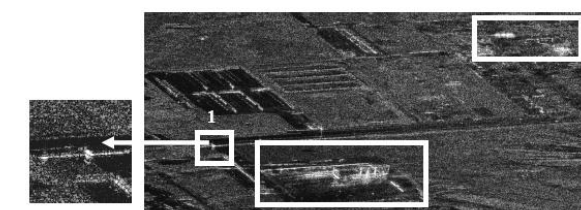
Figure 2 Airborne SAR original image